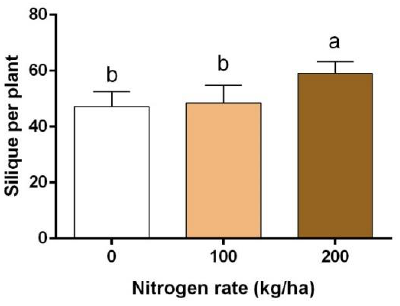
Figure 4. Effects of N application on siliques per plant. Different letters on the top of the bars indicate significant difference at p < 0.05 by Duncan. Table 4. Effects of N and P application on seed yield and yield components of rapeseed.